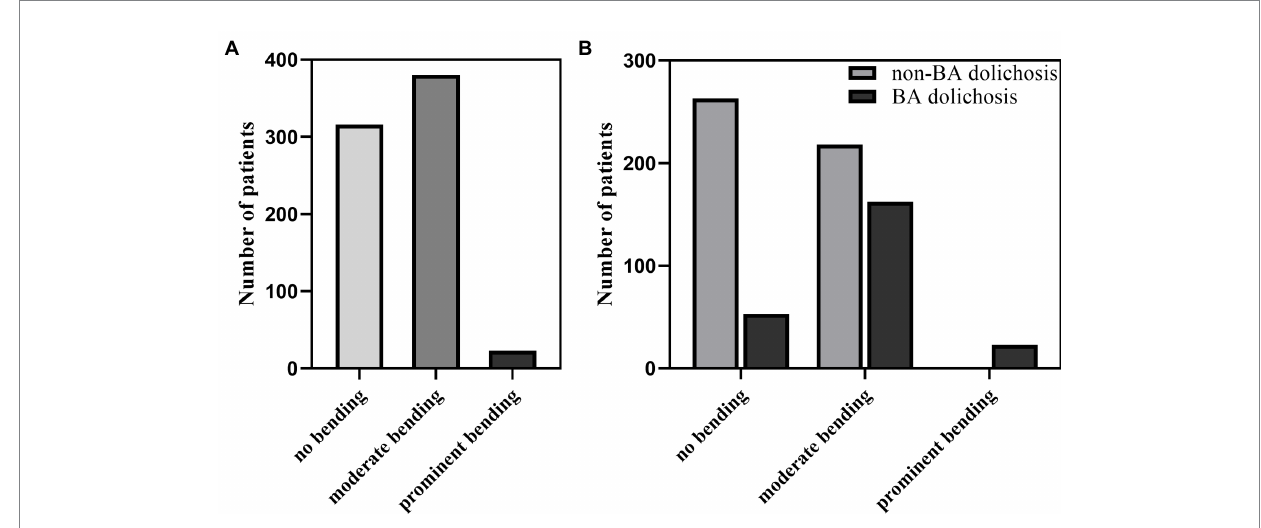
FIGURE 1 BA bending distribution in the entire study population (A) ; BA bending distribution in patients with BA dolichosis and non-BA dolichosis (B)